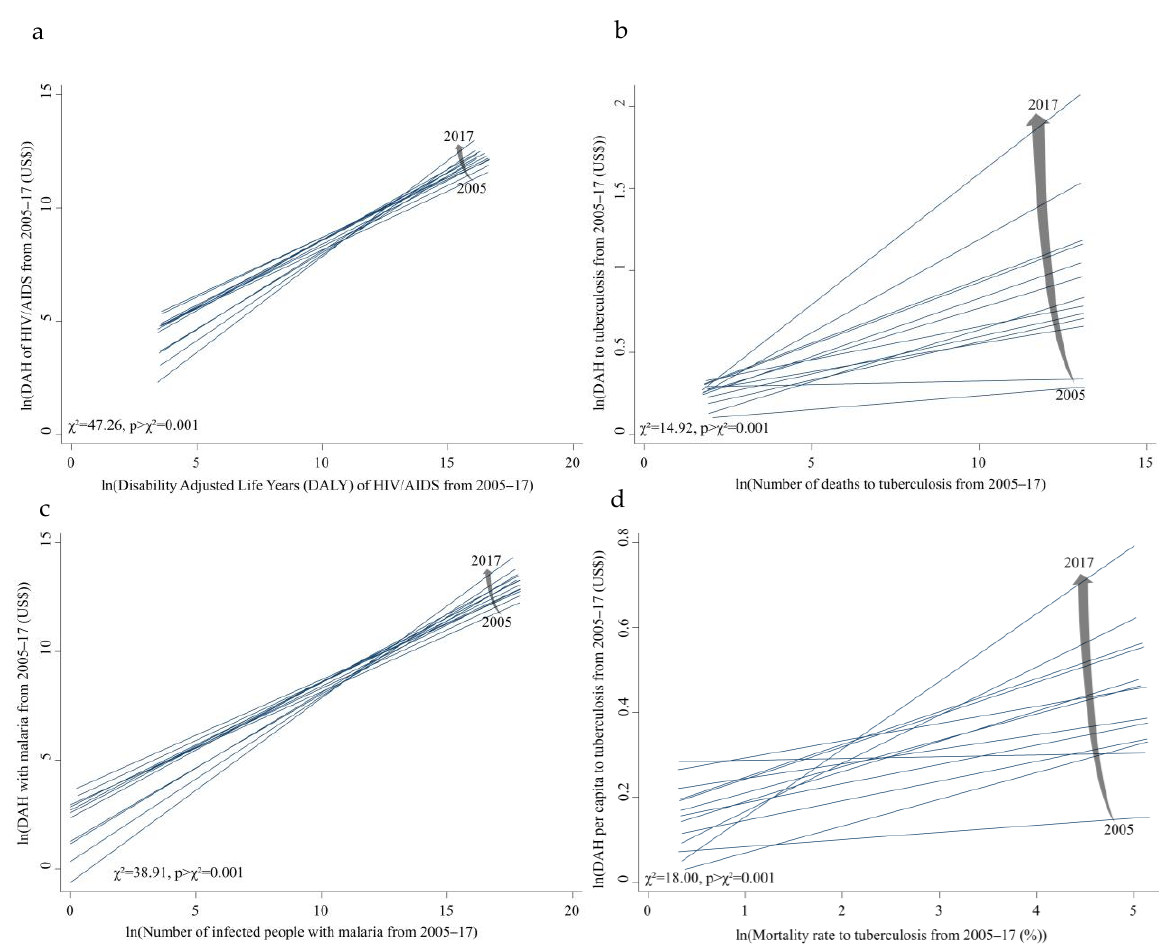
Figure 4. Slope of the linear fitted regression line, 2005–2017, ( x -axis: disease burden, log transformation, y -axis: DAH or DAH per capita (US$), log transformation). ( a ) DAH and Disability Adjusted Life Years (DALY) of HIV/AIDS from 2005 throughout 2017. ( b ) DAH and number of deaths to TB from 2005 throughout 2017. ( c ) DAH and number of infected people with malaria from 2005 throughout 2017. ( d ) DAH per capita and mortality rate to TB from 2005 throughout